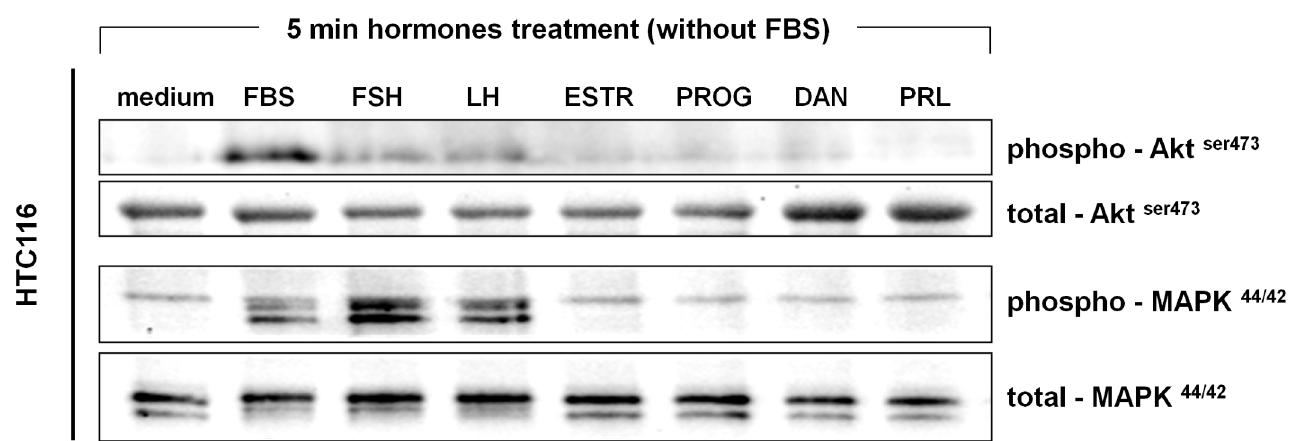
Fig 5. Phosphorylation of the intracellular kinase p42/44 mitogen-activated protein kinase (p42/44 MAPK) and AKT in HTC116 cells. The experiment was repeated twice with similar results, and representative data are shown. ll studied hormones were tested in serum-free medium (without FBS).